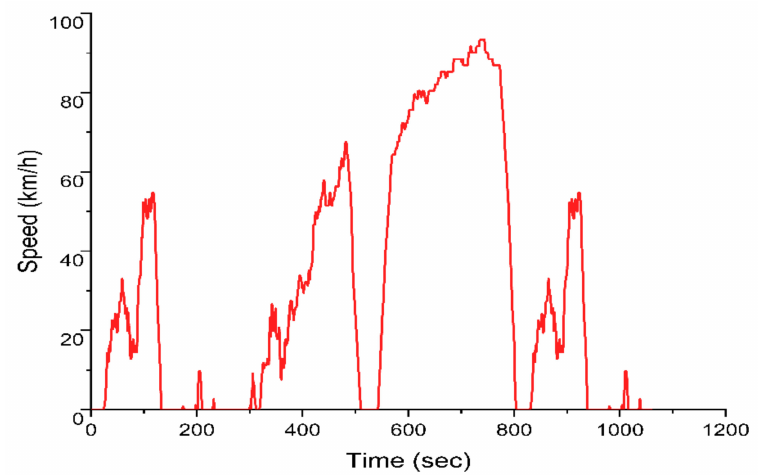
Figure 14. Speed profile of Heavy-Duty-Urban Dynamometer Driving Schedule (HD-UDDS) drive